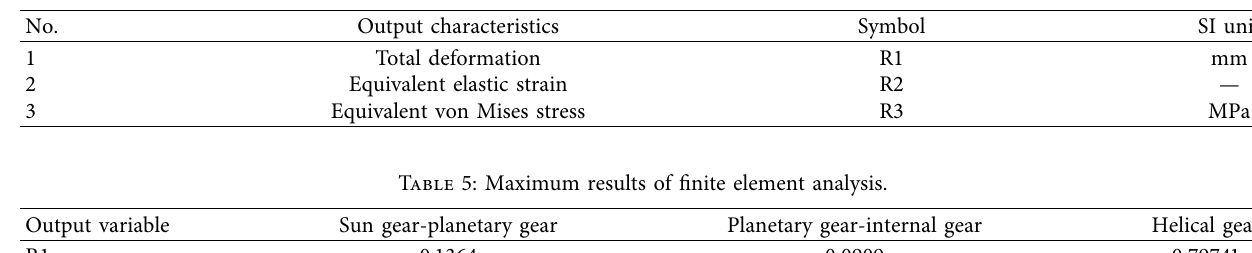
Figure 21: Root stress of the helical gear group. (a) Root stress cloud of the helical gear. (b) Root stress cloud of the drive gear. Table 4: Output response of finite element analysis.